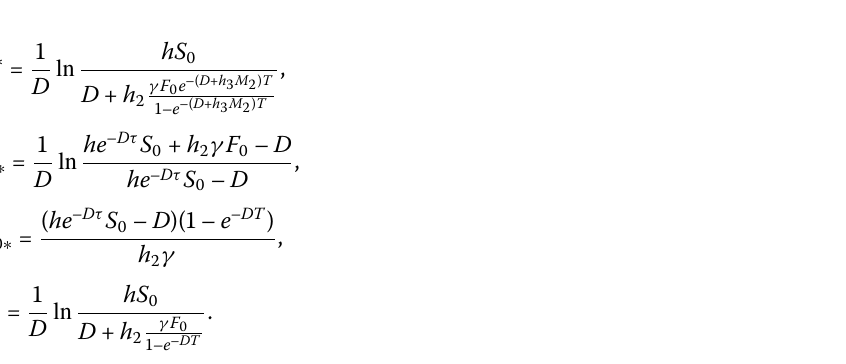
Figure 3 Dynamical behavior of solutions of system (26) with R 1 = 0.9910 < 1. (a) Time series of S ( t ), x ( t ), F ( t ). (b) Three-dimensional phase diagrams of S ( t ), x ( t ), F ( t ). (c) Phase diagrams of x ( t ), F ( t ). (d) Phase diagrams of x ( t ), S ( t